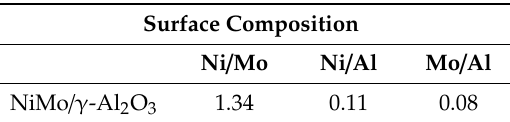
Table 2. XPS surface